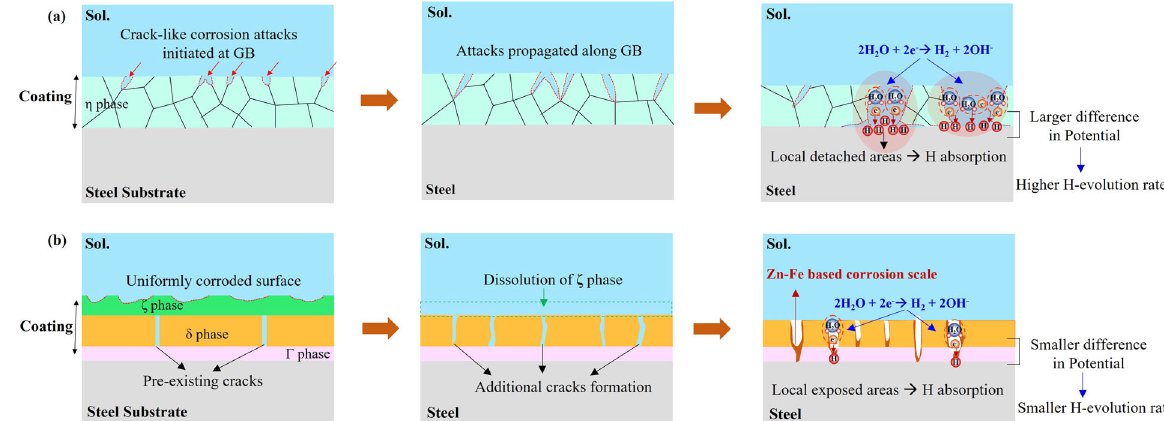
Fig. 14 Schematic diagrams of the corrosion and hydrogen penetration mechanisms. a, b GI and GA-coated steels, respectively.